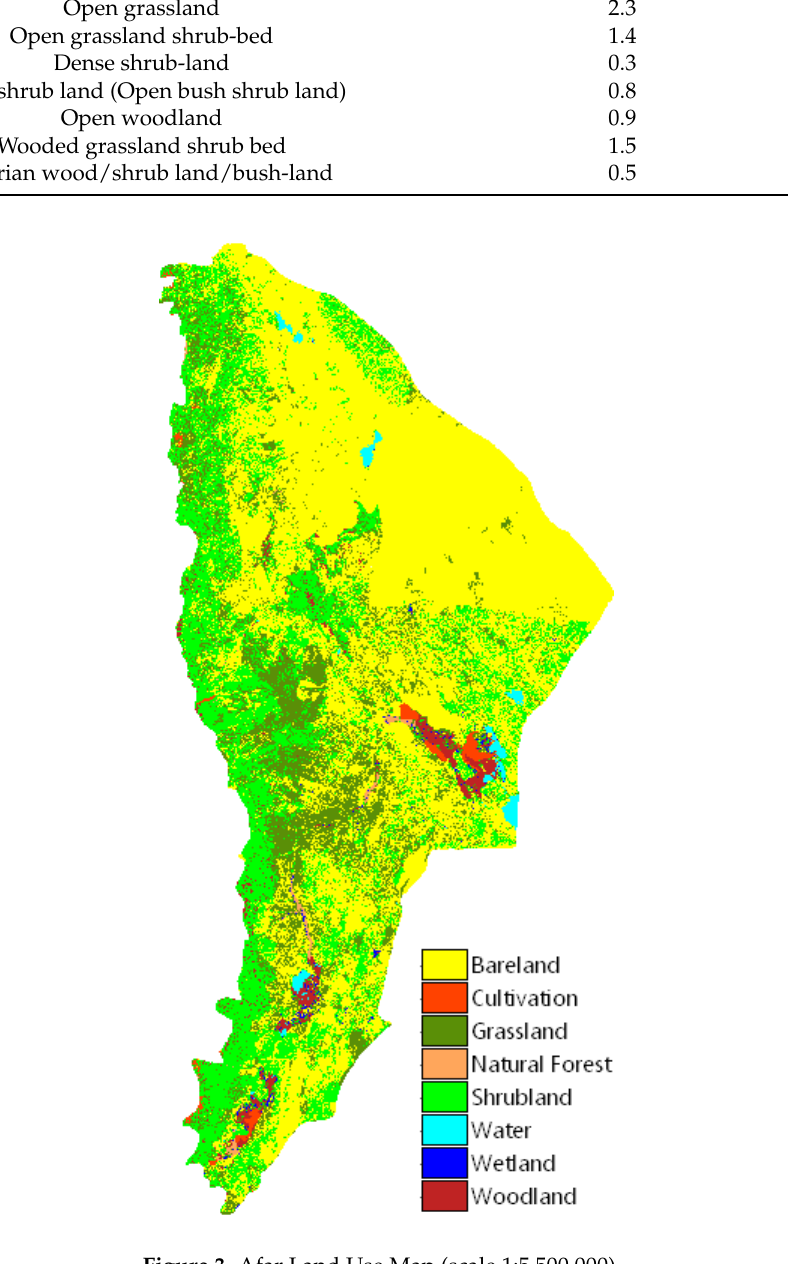
Table 2. Biomass production by land use [60].